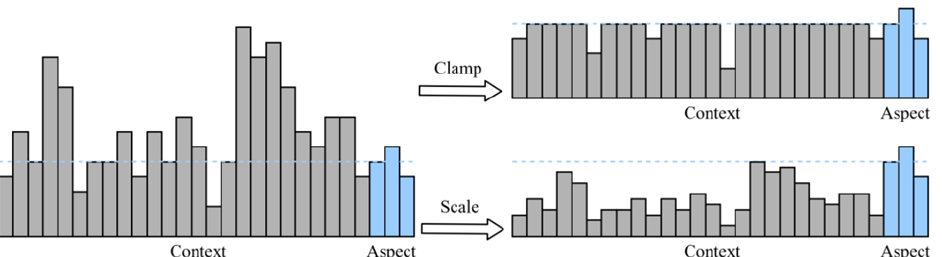
Figure 3. Adaptive scale mechanism of attention. For paying more attention to the context than the aspect phrases, an adaptive scale mechanism on the contextual attention is used according to their correlations with aspect phrases, rather than a clamp mechanism to tailor the contextual attention according to the aspect